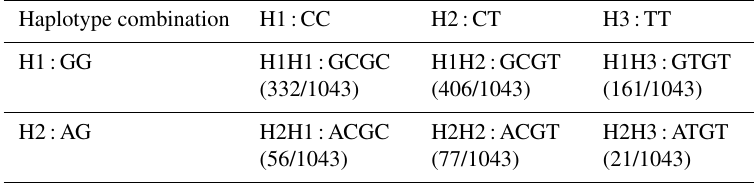
Table A7. All haplotype combinations in the